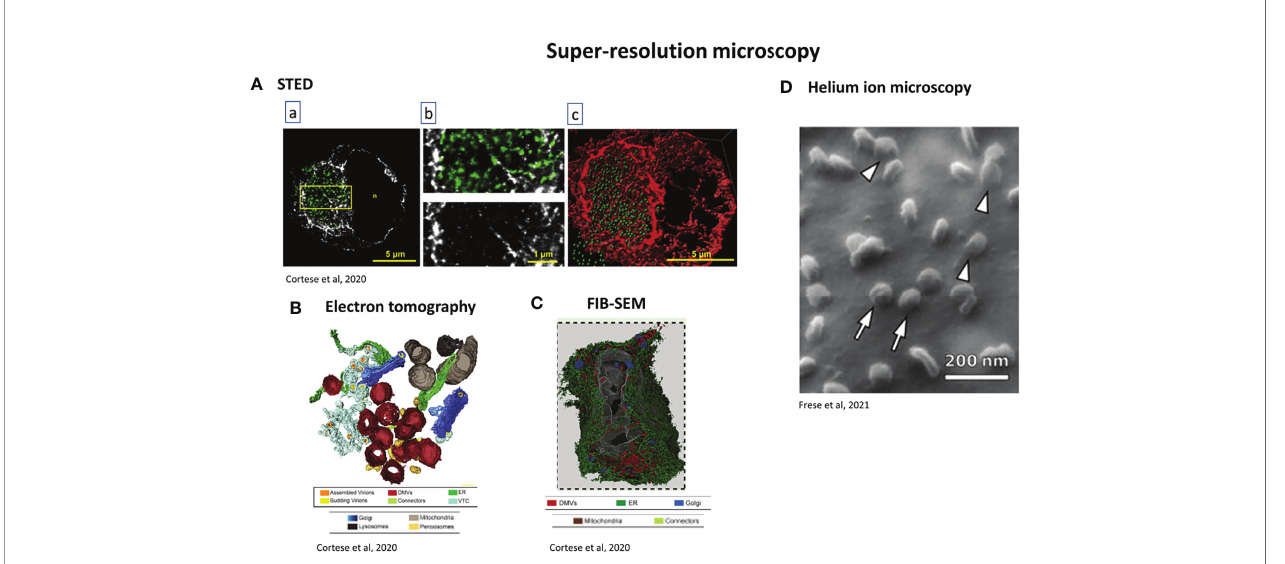
FIGURE 8 | Examples of super-resolution techniques used for studying SARS-CoV-2. (A) STED microscopy. A549-ACE2 cells were infected with SARS-CoV-2 for 16 h, fi xed and stained. (a) Green: dsRNA, gray: vimentin. Scale bar: 5µm. The region in the yellow box is magni fi ed in b, Scale bar: 1µm. (c) 3D rendering of the dsRNA and vimentin signals after z-stacking. Scale bar: 5µm (Cortese et al., 2020). (B) 3D rendering of electron tomography of Calu-3 infected cells. Colour code at the bottom of the picture. It shows the spatial coupling of SARS-CoV-2 replication and assembly sites mediated by close proximity of DMVs, vesicular-tubular compartment and Golgi apparatus (Cortese et al., 2020). (C) FIB-SEM analysis of whole-cell volume of a SARS-CoV-2-infected Calu-3 Cell. Cells were infected 24h before fi xation. 3 dimensional rendering of one infected cell. Colour code at the bottom of the fi gure. This reveals the network of DMVs and ER (Cortese et al., 2020). (D) Helium ion microscopy of SARS-CoV-2 infected cells. Arrowheads: viruses which appear to be bound to the cell membrane; arrows: viruses which appear to lie on the top of the cell membrane (Frese et al.,